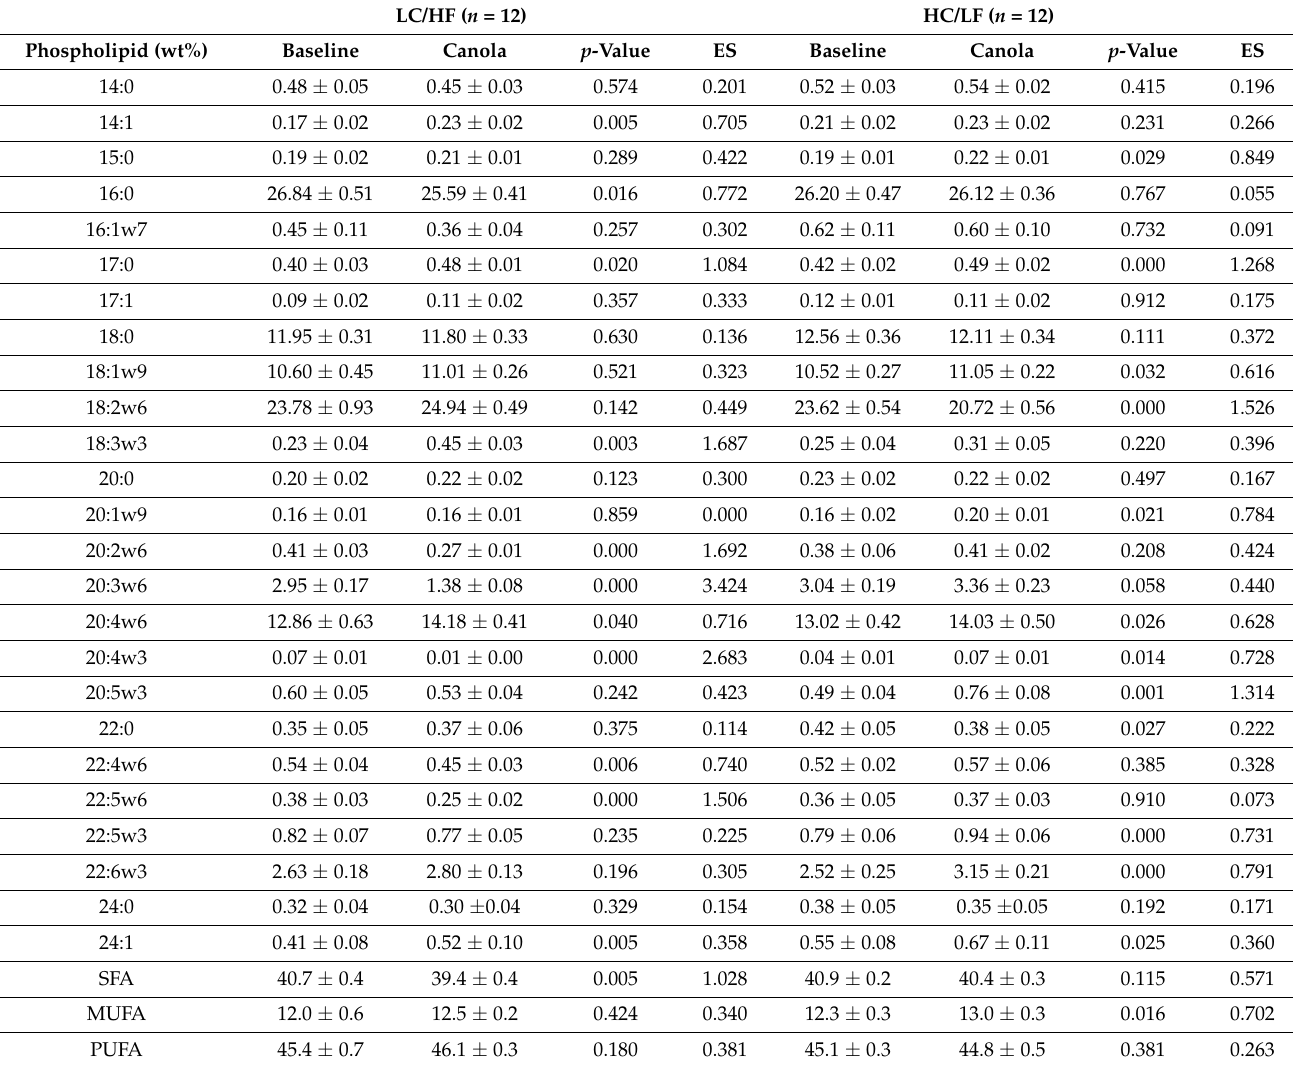
Means ± SEM. p -values are derived from dependent t -tests. ES = Effect Size. SFA = saturated fatty acids, MUFA = monounsaturated fatty acids, PUFA = polyunsaturated fatty